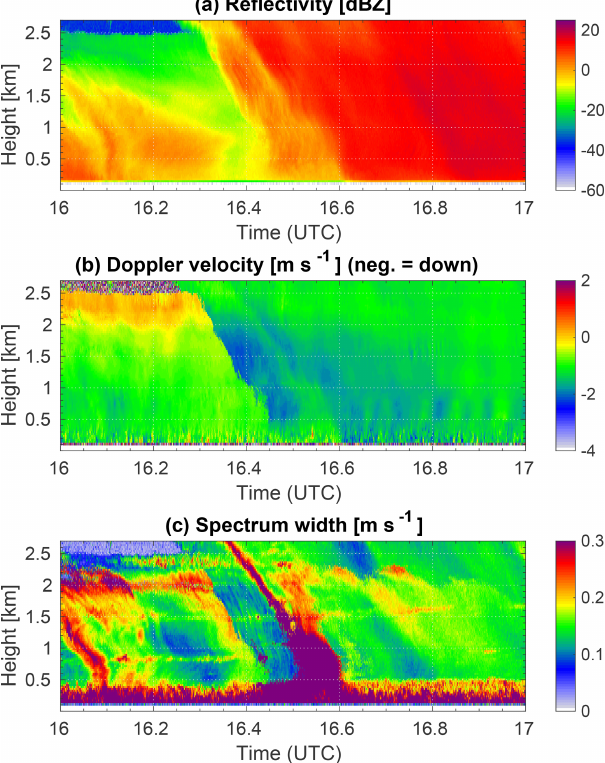
Figure 9. Like Fig. 4 but for 2 February 2014, 16:00 to 17:00UTC, at 0 to 2.7km